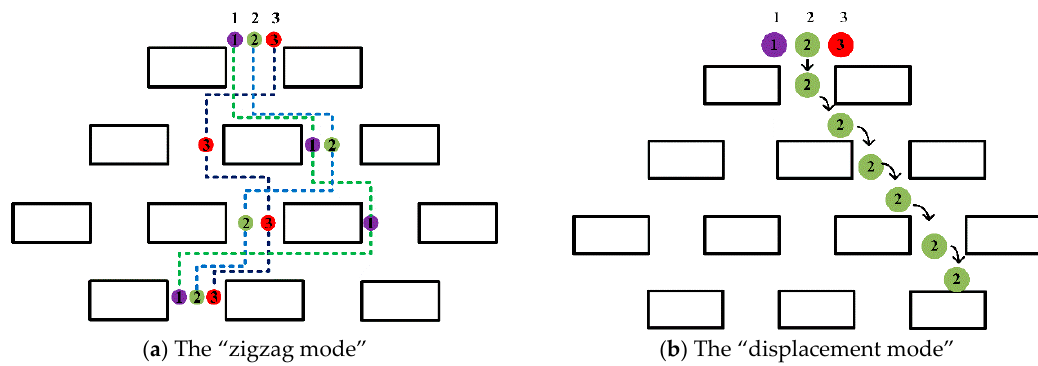
Figure 3. A schematic diagram of a human-defined barrier matrix with three fluid channels. ( a ) The three microspheres in the channel (shown in purple, green, and red, respectively) are incompatible. After three rows of obstacles, the trajectories of the microspheres return to the original channel position, following a zigzag pattern. ( b ) The microspheres with a radius which is greater than the width of the channel follow a displacement pattern, passing through the streamline at the center of the microspheres. The arrow marks the trajectories of the microsphere.